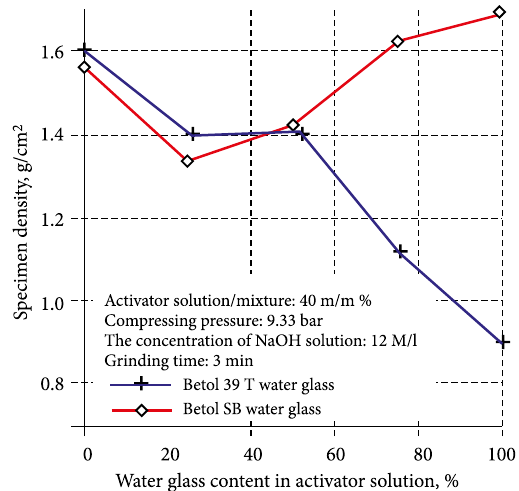
Fig. 6. Change of specimen density as function of water glass content in activator solution